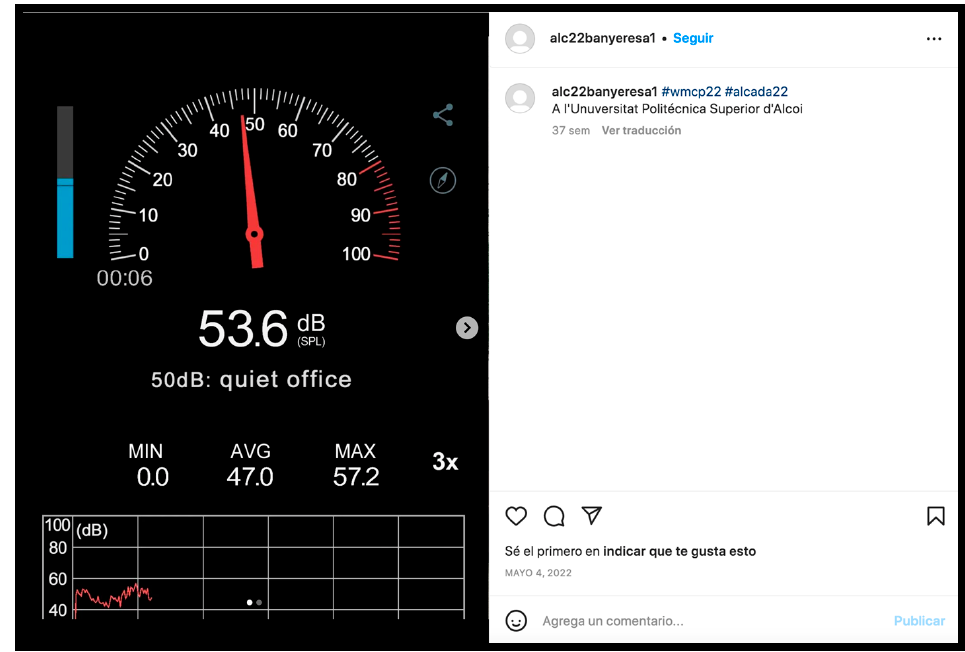
Figure A1. Example 1 of the test with the app: Sound meter. Notes: #wmcp22 #alcada22 At the Higher Polytechnic University of Alcoy.